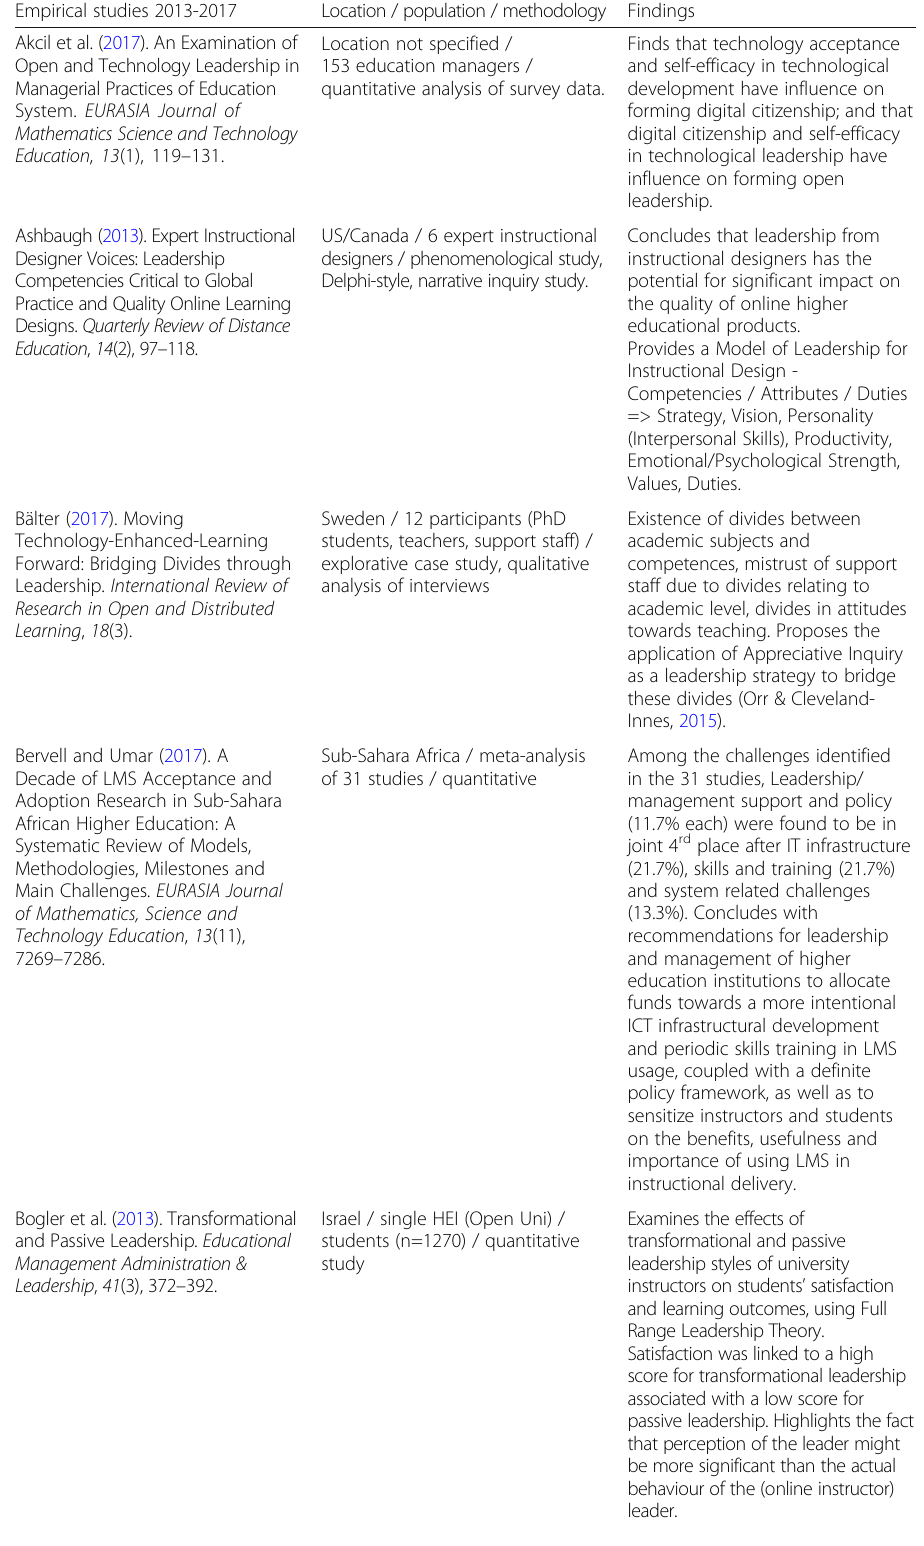
Table 2 Results: Empirical